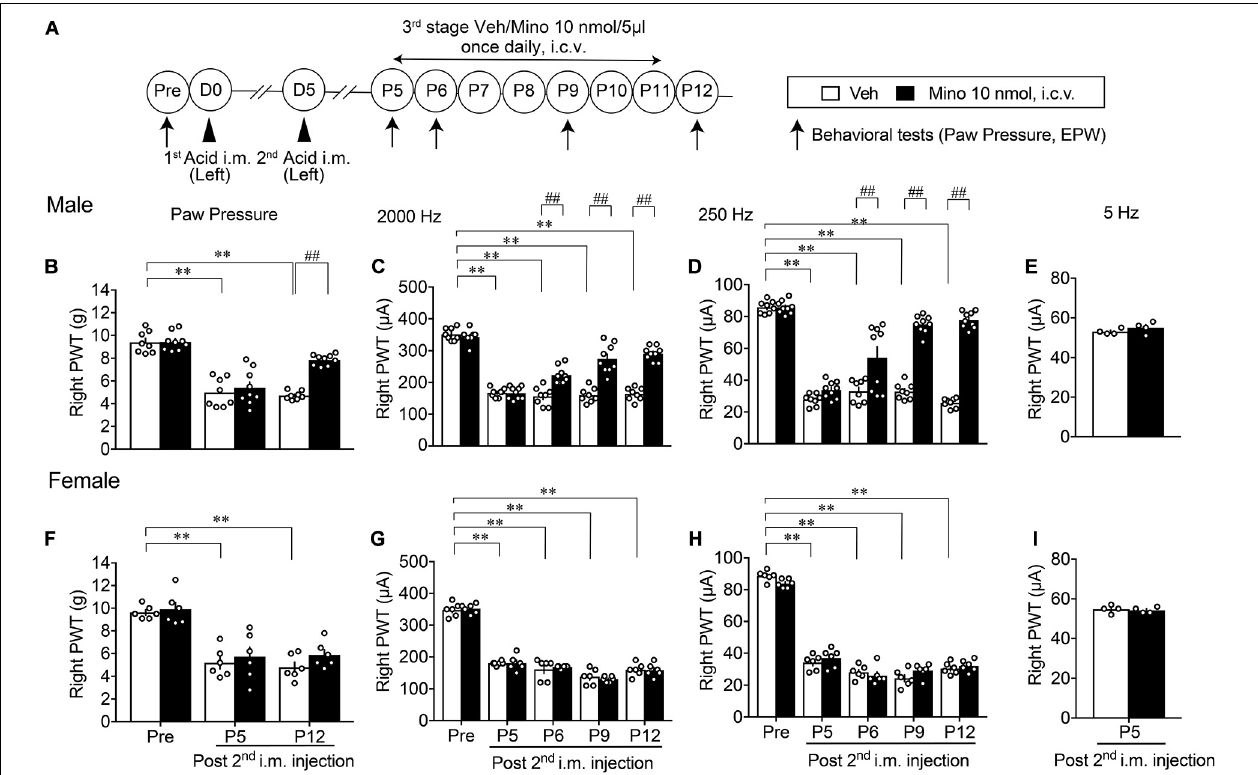
FIGURE 5 | Effective blockade of AcGP by 3rd stage of minocycline treatments. Details are described in the legend of Figure 3 , except for the minocycline treatments (P5 to P11; A ). For (B–D) and (F–H) , ∗∗ p < 0.01, compared with basal threshold prior to vehicle injection (Pre Veh), in two-way repeated measures ANOVA followed by Dunnett’s multiple comparisons test. ## p < 0.01, compared with each time point at Veh, in two-way repeated measurement ANOVA followed by Bonferroni’s multiple comparisons test (Male Veh, n = 8; Mino, n = 9; and Female, n = 6). For (E,I) , P = 0.2666 (E) , and P = 0.7084 (I) , compared with Mino 10 nmol, i.c.v., in unpaired t test ( n = 4). The dots in the column represent number of animals. AcGP, acid saline-induced FM-like generalized pain; Mino, minocycline; and PWT, paw withdrawal